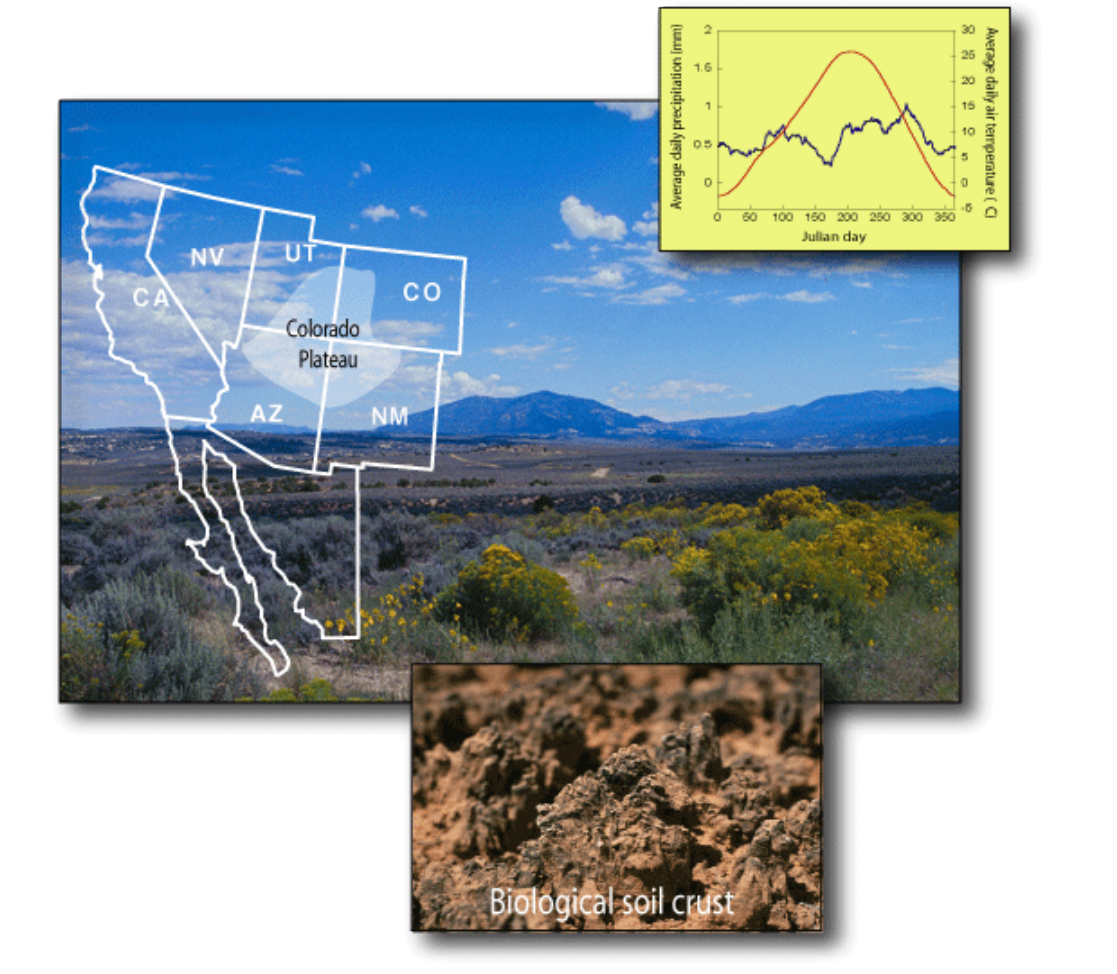
Fig. 1. The Colorado Plateau. Top inset: climate diagram for the Needles District of Canyonlands National Park, southern Utah. Blue: average daily precipitation, red average daily temperature. Data courtesy of the Western Regional Climate Center. Lower inset: biological soil crust, showing a pinnate crust surface, typical for the Colorado